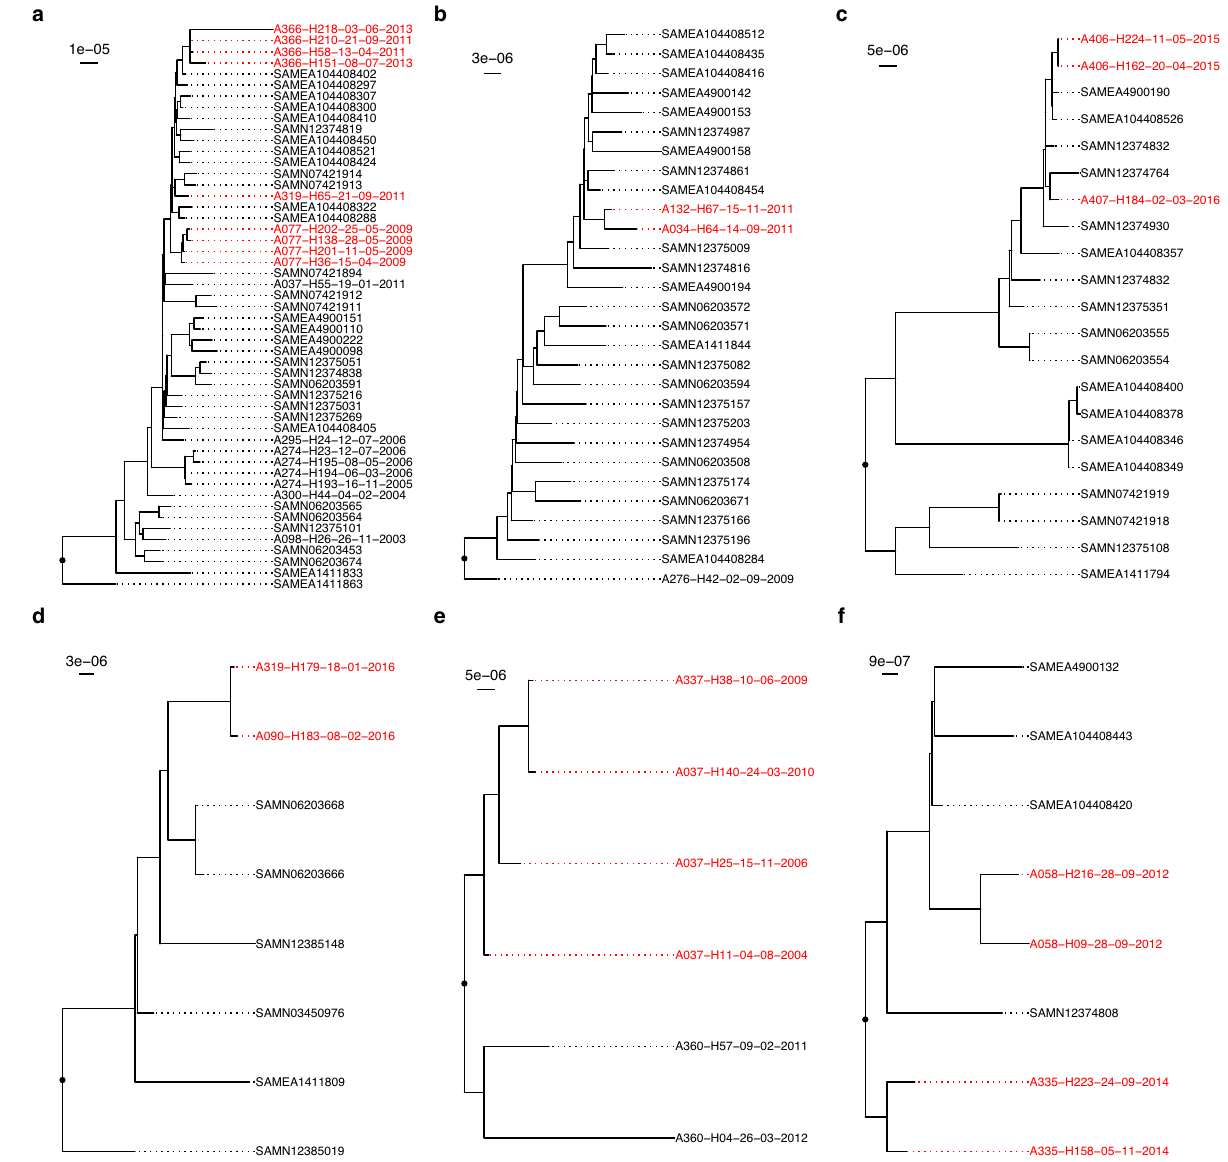
Figure 3. Maximum likelihood consensus phylogenies for STs with patient-pairs of interest. ( a ) ST-12, ( b ) ST-103, ( c ) ST-145, ( d ) ST-321, ( e ) ST-393, and ( f ) ST-1034. Publicly available genomes are indicated by their BioSample accessions. Isolates colored red belong to patient-pairs with possibly transmitted isolates and are separated by p-distances smaller than the threshold (1.68 × 10 −5 SNPs per site) for potential transmission. Isolate names are given in the format “Patient Number”-“Isolate Number”-“Collection Date (DD-MM-YYYY)”. Scale bars for each tree are given in the units SNPs per site. Branch nodes with > 95% Ultrafast bootstrap support are